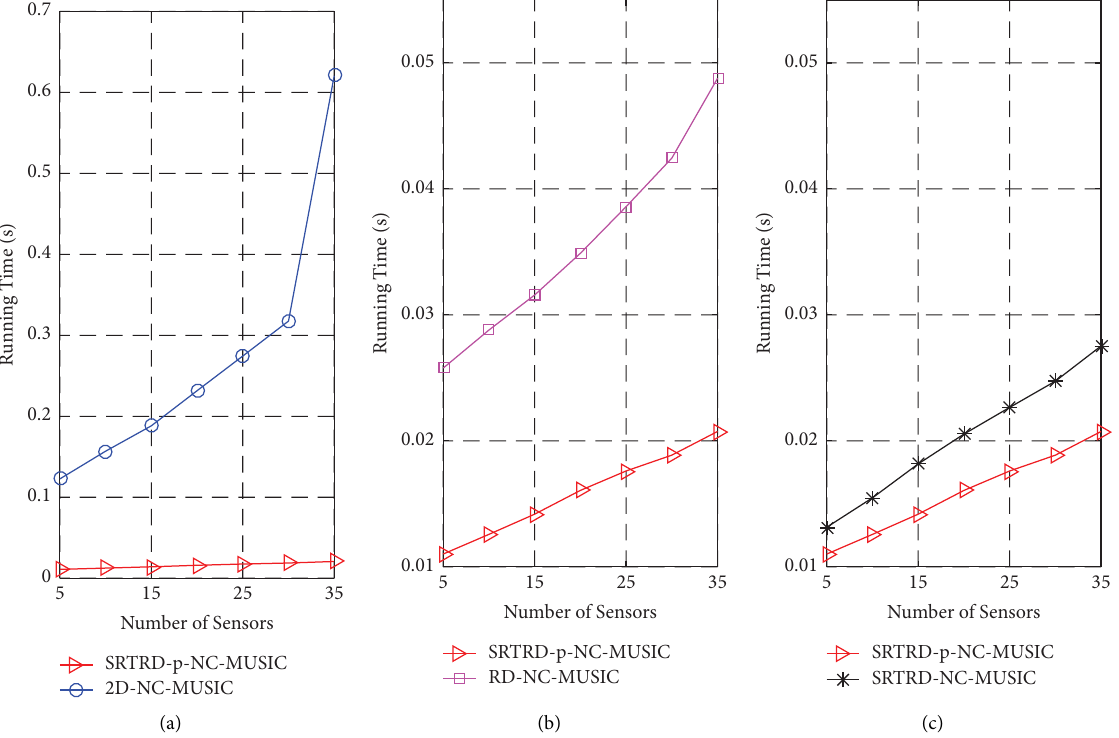
Figure 12: Running time comparison with a diferent number of sensors, SNR � 10dB and L �